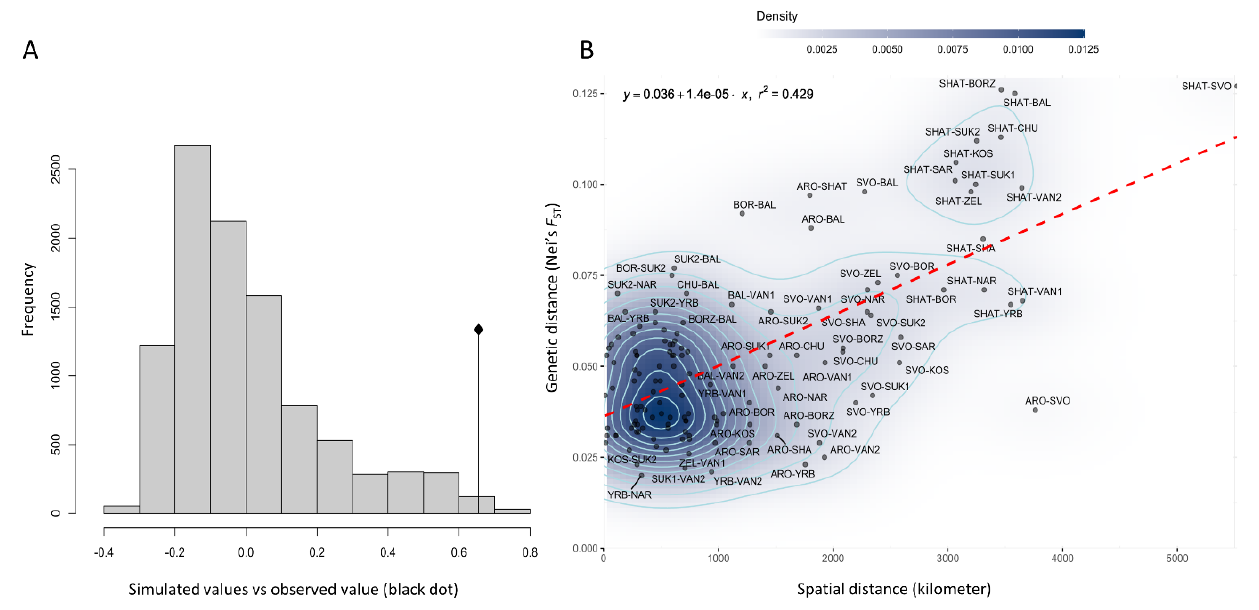
Figure 5. Isolation-by-distance analyses (IBD), including the output of a Mantel test ( A ), were performed to indicate the empirical genetic distance vs. geographic distance correlation (black dot), which was plotted over a histogram of Monte Carlo simulations in the absence of spatial structure. A kernel density estimate of pairwise correlations revealing multiple clusters ( B ). Acronyms are as in Table 1.